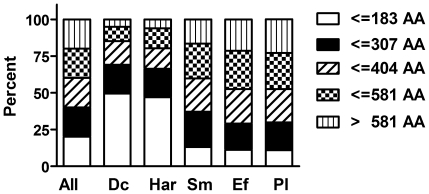
Peptide length of induced transcripts.Transcripts up-regulated upon fungal infection are on average shorter than those induced by bacterial infection. All transcripts were divided into five classes based on the length of the encoded proteins as shown (AA: amino acid). Bar diagram showing the percentages of transcripts coding for proteins with a certain length in the list of all transcripts and in the lists of up-regulated transcripts for different pathogens (RNA-seq). All: all transcripts; Dc: D. coniospora; Har: Harposporium sp.; Sm: S. marcescens; Ef: E. faecalis; Pl: P. luminescens.